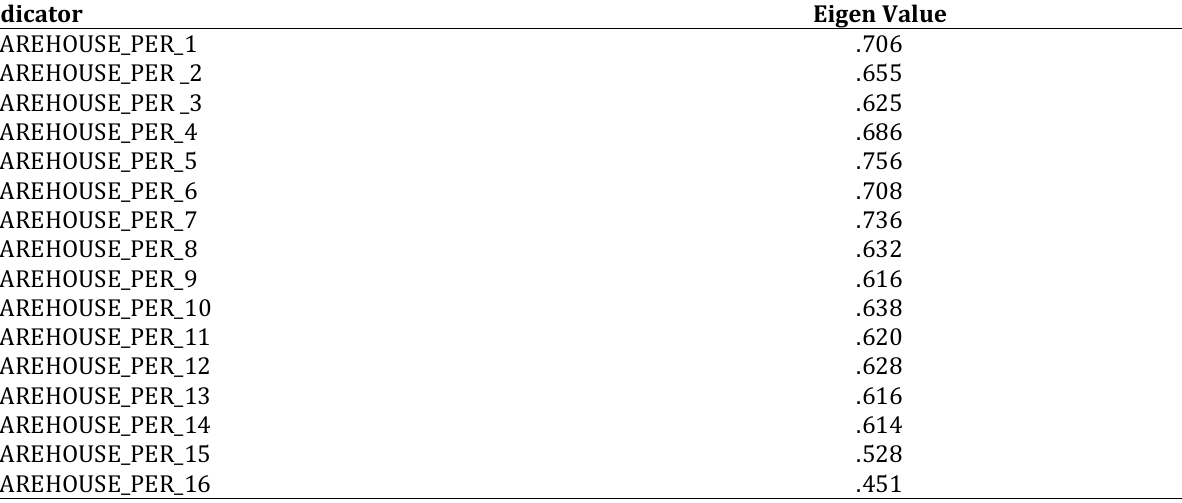
Table 17: gives the corresponding Eigen scores of the first principal component Indicator